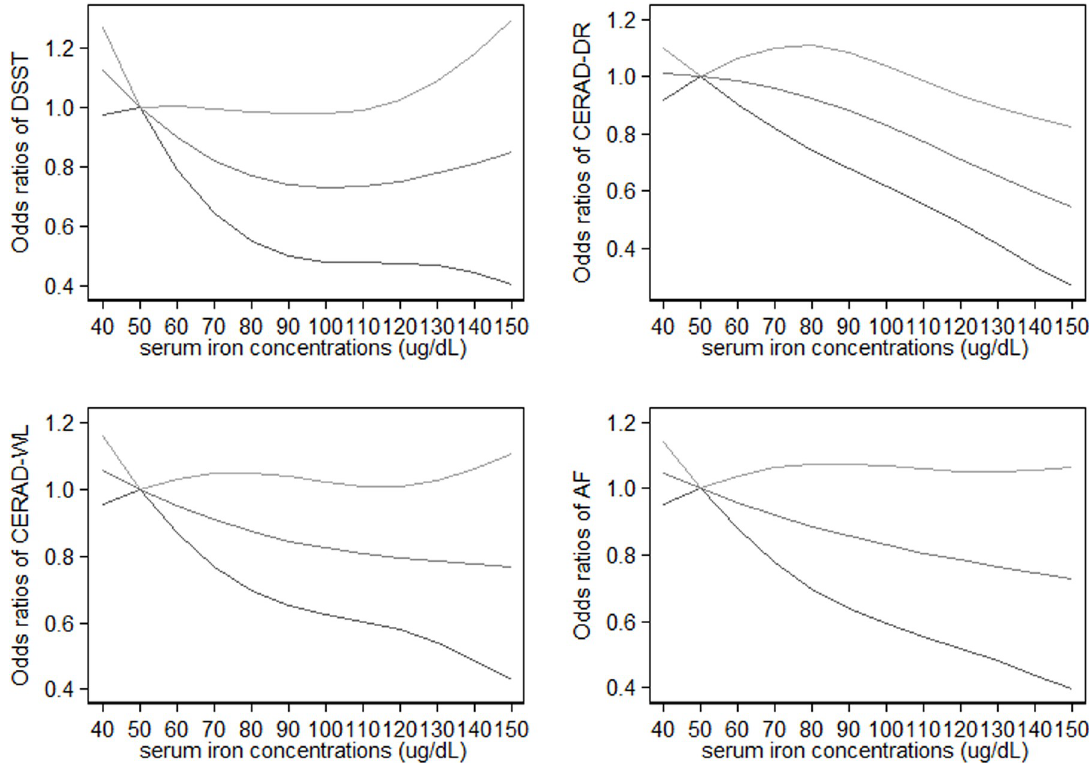
Fig 1. Dose-response relationship between serum iron concentrations and the odds of scoring low on the DSST, CERAD-DR, CERAD-WL and AF in older adults, respectively. The middle line and upper and lower line represent the estimated odds ratio and its 95% confidence interval, respectively. AF: the Animal Fluency, CERAD-DR: the Consortium to Establish a Registry for Alzheimer’s Disease Delayed Recall, CERAD-WL: the Consortium to Establish a Registry for Alzheimer’s Disease Word Learning, DSST: Digit Symbol Substitution